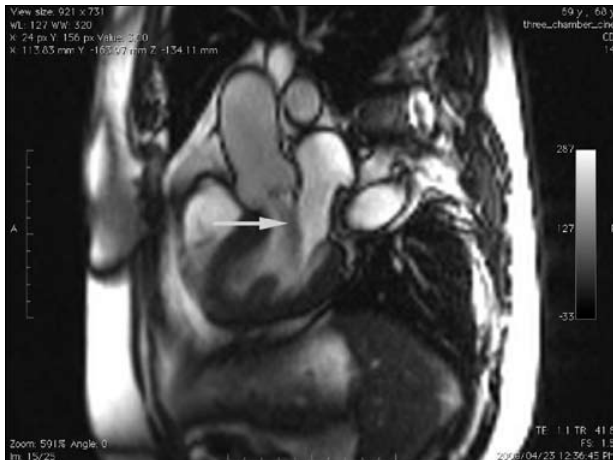
Fig. 4. Gradient echo bright blood image in the plane of the left ventricular outflow showing prominent low signal (spin dephasing) owing to turbulent flow from aortic regurgitation (arrow), leading to early closure of the mitral valve anterior